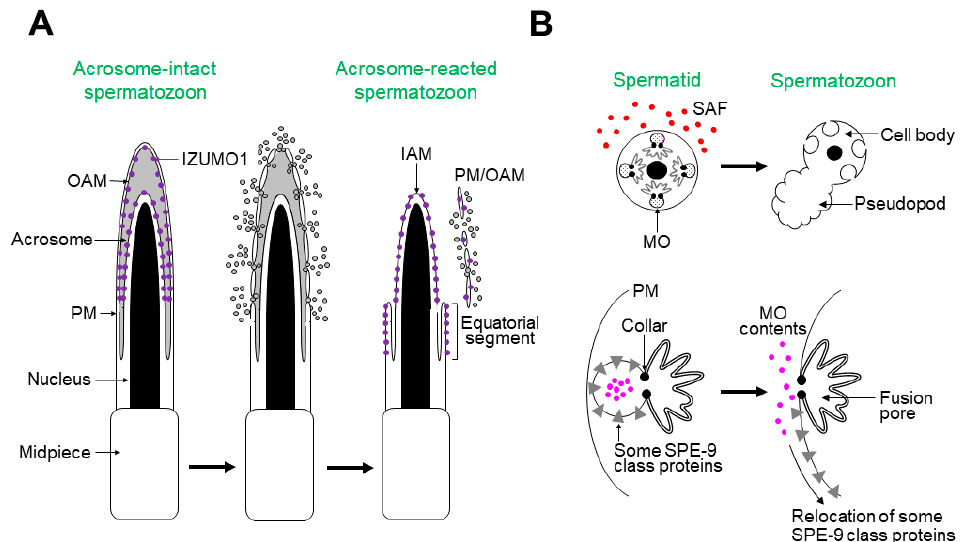
Figure 2. The acrosome reaction in mice and MO fusion in C. elegans . ( A ) The acrosome reaction is a sperm activation event during capacitation. After initiation of the acrosome reaction, the PM and OAM fuse at multiple sites, resulting in the extracellular release of acrosomal contents (gray-colored circles). IZUMO1 (purple-colored circles)—a sperm protein essential for gamete fusion—relocates to the surface of the equatorial segment, where the spermatozoa bind to and fuse with the oocyte PM. In this panel, the flagellum is omitted. ( B ) ( Upper panel ) A C. elegans spermatid intracellularly contains numerous MOs. After stimulation with in vivo or in vitro SAFs (red-colored circles), a pseudopod extends from the cell, forming a motile amoeboid spermatozoon. ( Lower panel ) Simultaneously, each MO fuses with the spermatid PM, and MO contents (pink-colored circles) are released extracellularly. The MO collars leave a permanent fusion pore. During acrosome reaction, some SPE-9 class proteins, which are essential for fertilization, relocate onto the pseudopod or entire spermatozoon. This illustration is a modi fi cation of a fi gure in [9].